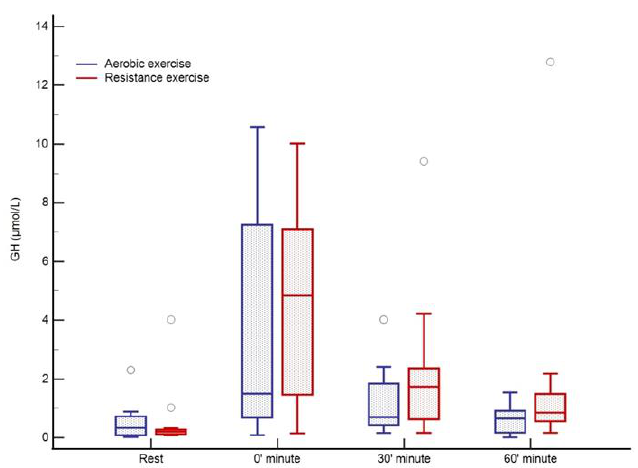
Figure 4. Cortisol response to aerobic versus resistance training. The box-and-whisker plot displays the following: the median value (solid line within the box); the interquartile range (2 ends of the box); either the 5th or 95th percentile values or the smallest and largest observations (2 lines with caps extending from the box, the so-called whiskers); and any extreme outliers.